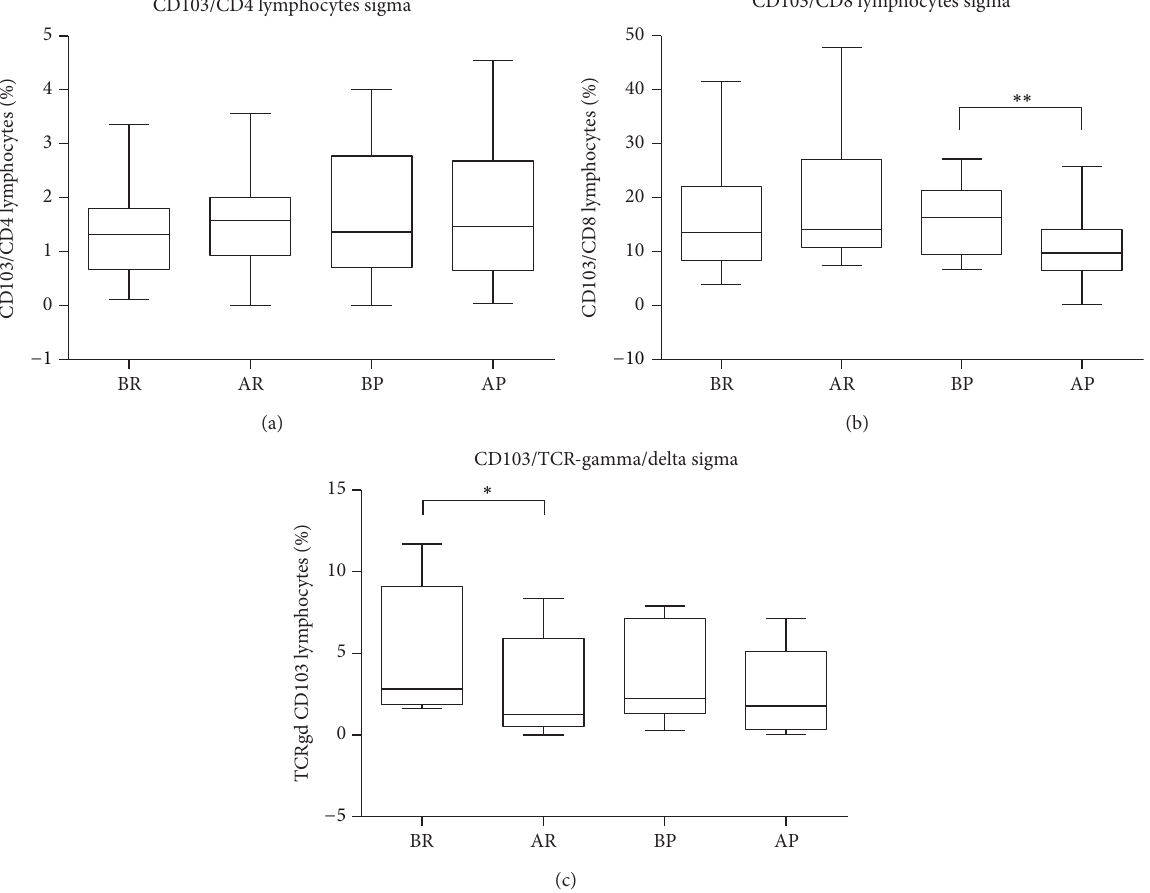
Figure 4: Expression of CD103 in lymphocytes of sigma mucosa. (a) Percentage of CD103 in CD4 lymphocytes subpopulation after Rifaximin and placebo treatments. (b) Percentage of CD103 in CD8 lymphocytes subpopulation after Rifaximin and placebo treatments. (c) Percentage of TCR-gamma/delta CD103 lymphocytes subpopulation after Rifaximin and placebo treatments. The values reported in box-and-whiskers plots show the minimum, the 25th percentile, the median, the 75th percentile, and the maximum. In particular, the whiskers go down to the smallest value (minimum) and up to the largest one (maximum), the top and bottom of the box are the 25th and 75th percentiles, and the line in the middle of the box is the median corresponding to 50th percentile ( ∗ 𝑃 < 0.05 before versus after treatments in patients); before Rifaximin (BR), after Rifaximin (AR), before placebo (BP), and after placebo